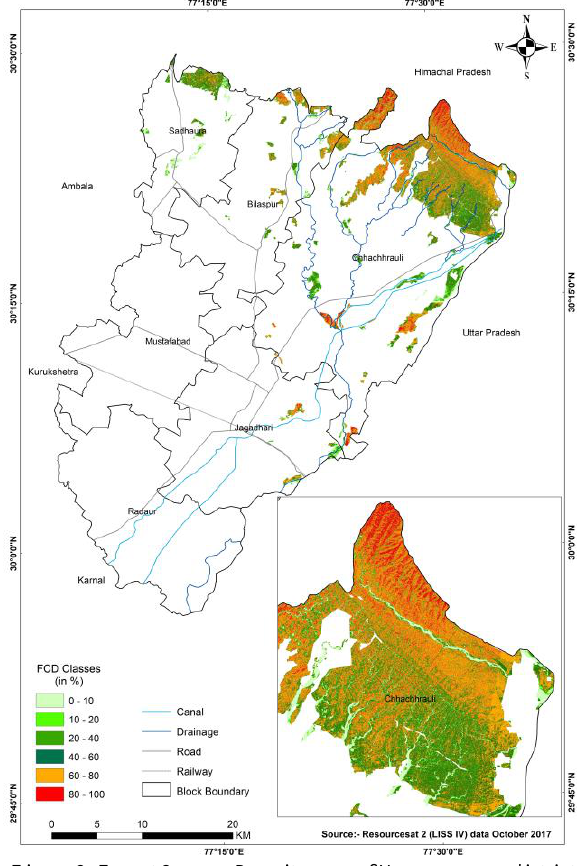
Figure 3. Forest Canopy Density map of Yamunanagar district